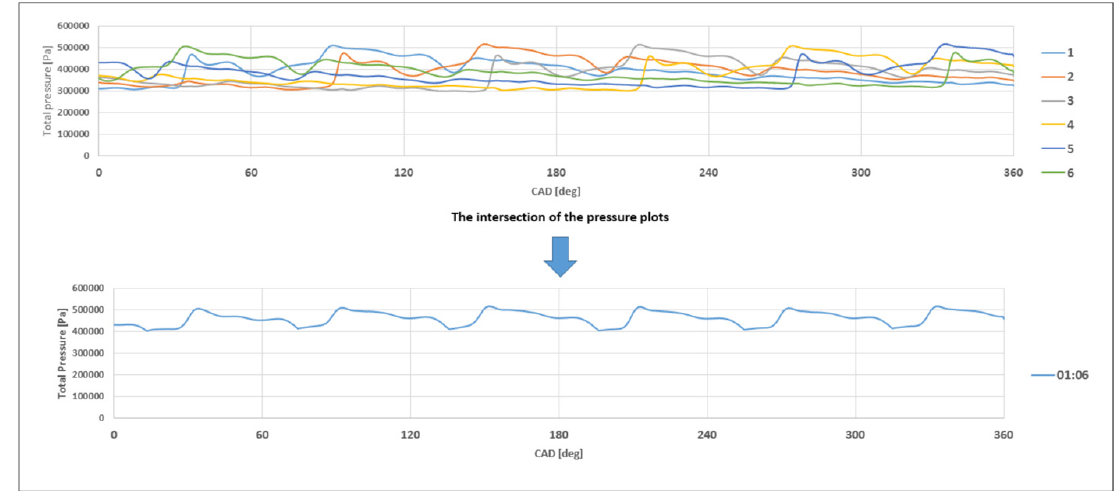
Figure 15. Example of the intersection of the pressure plots monitored at the Section 6.1 at the turbine speed of 40,000 rpm and 11 ◦ VTG opening.